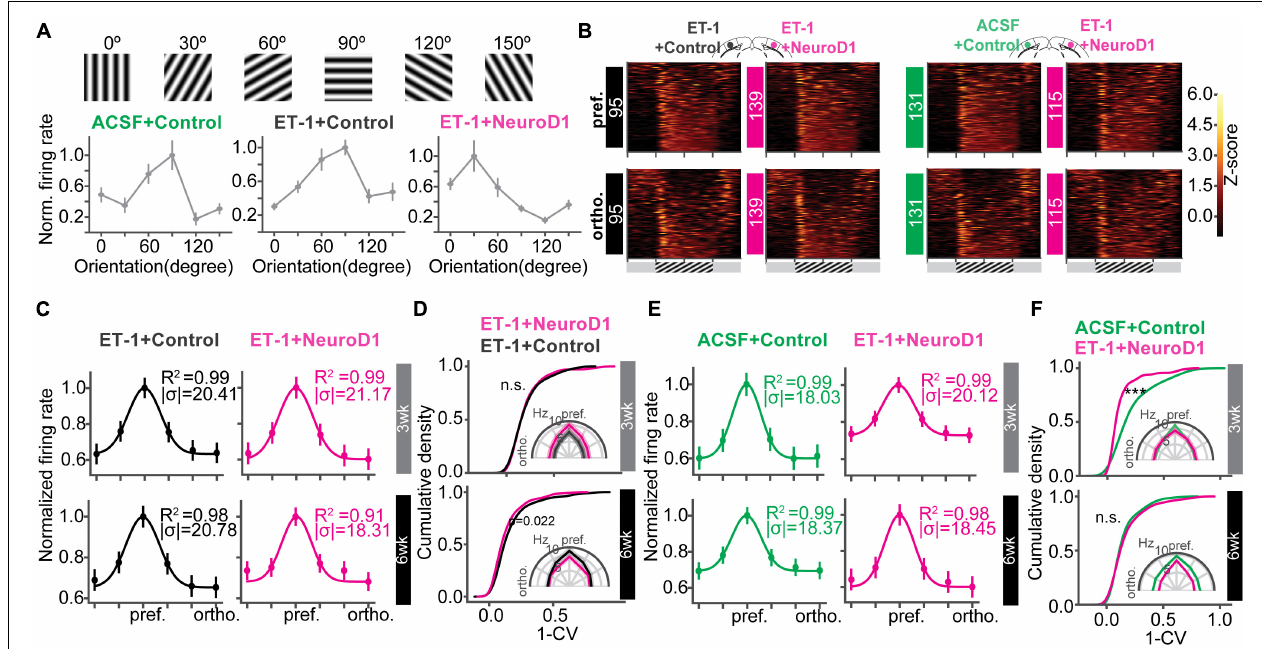
FIGURE 6 | Orientation selectivity of the local neuronal population is improved over time. (A) Gratings of 6 orientations used to measure orientation selectivity. Bottom: normalized firing rate of representative units for each group. (B) Heatmaps of firing rate z-scores of all units in response to the preferred (pref., top) and the orthogonal (ortho., bottom) orientations for each group. (C) The curves showing unit averaged firing rates to 6 orientations normalized and fitted with Gaussian functions of the “ET-1+NeuroD1 vs. ET-1+Control” group at 3 weeks and 6 weeks post-infection. The insets showing the coefficient of determination (R 2 ) and sigma of fitted functions. (D) Cumulative distributions of 1-CV of units in panel (C) . Inset, unit averaged firing rates to 6 orientations. 3 weeks: N ET − 1 + Control = 95 units, N ET − 1 + NeuroD1 = 139 units, from 6 mice, p = 0.954; 6 weeks: N ET − 1 + Control = 93 units, N ET − 1 + NeuroD1 = 142 units, from 4 mice, p = 0.022. 2-sample Kolmogorov-Smirnov test. (E) Same as (C) but for “ET-1+NeuroD1 vs. ACSF+Control” group. (F) Same as (D) but for “ET-1+NeuroD1 vs. ACSF+Control” group. 3 week: N ACSF + Control = 131 units, N ET − 1 + NeuroD1 = 115 units, from 4 mice, p = 1.659 × 10 − 7 ; 6 week: N ACSF + Control = 183 units, N ET − 1 + NeuroD1 = 172 units, from 8 mice, p = 0.652, 2 sample Kolmogorov-Smirnov test. *** p < 0.001 and n.s., not significant. Data are represented as mean ± SEM. See also Supplementary Figure 5